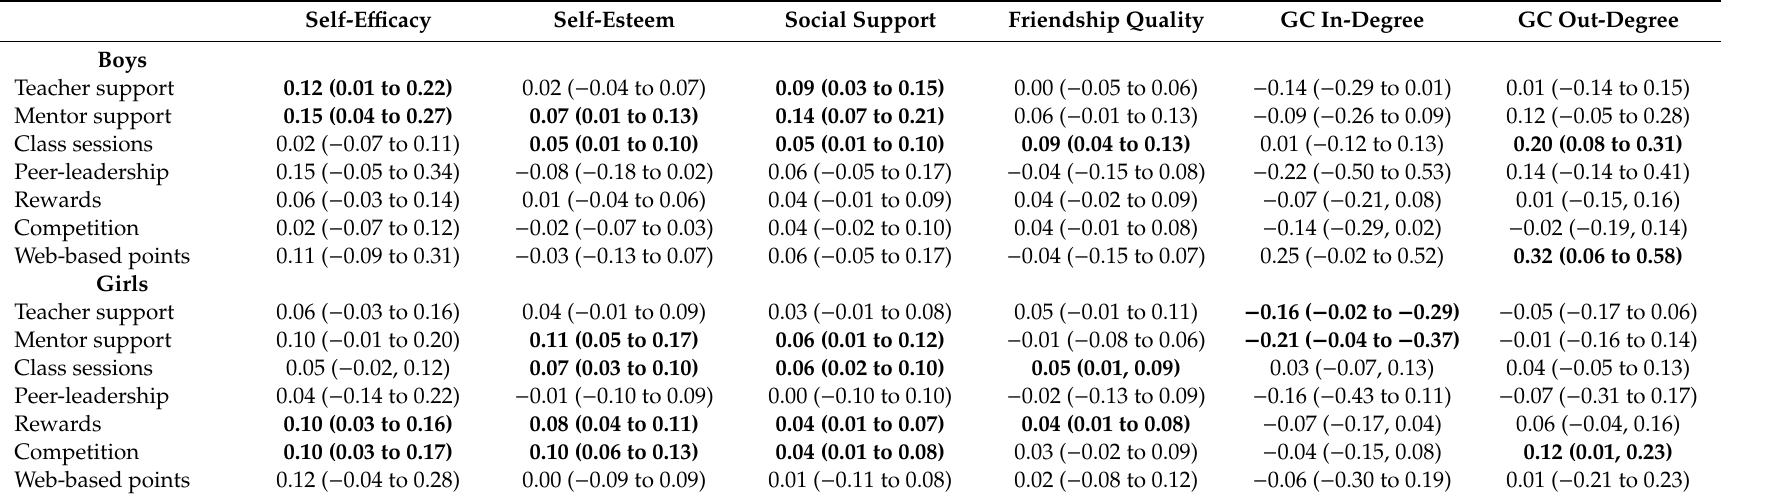
Table 4. Association between perception of intervention components and potential